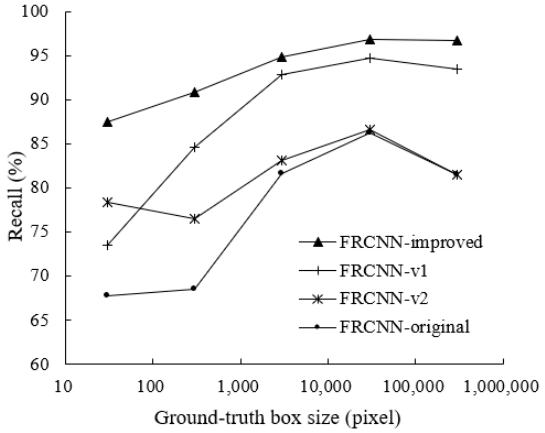
Figure 6. Recalls of the four Faster R ‐ CNN based models in different size intervals.